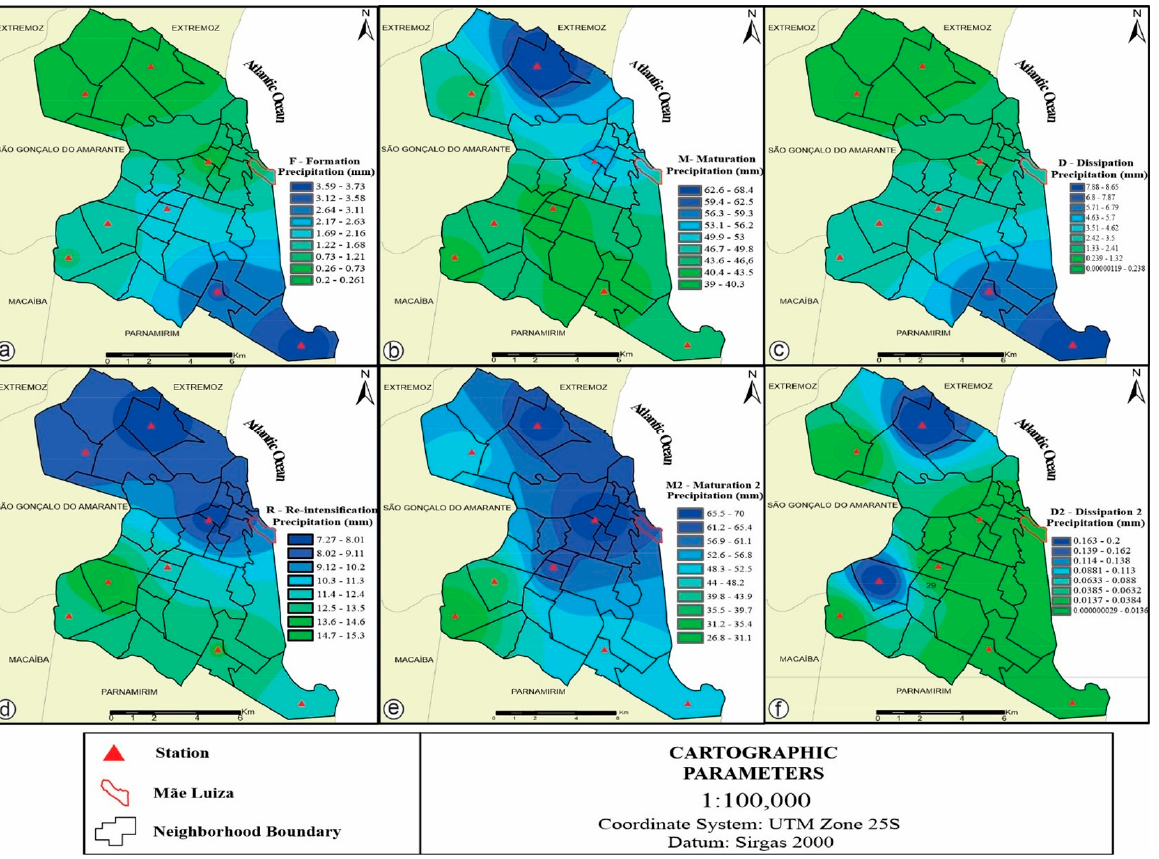
Figure 3. Accumulated rainfall in the city of Natal in three hours according to the phases of ( a ) formation, ( b ) maturation, ( c ) dissipation, ( d ) re-intensification, ( e ) 2nd maturation, ( f ) 2nd dissipation.